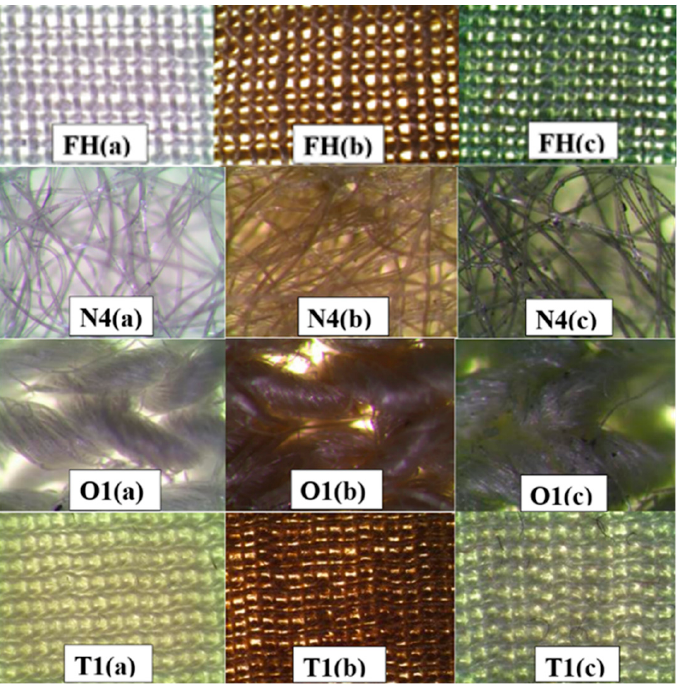
Figure 2. Micrographs of textile samples saturated with copper-containing particles. Raw material samples ( a ), material samples treated with reducer solutions No. 1 ( b ) and No. 2 ( c